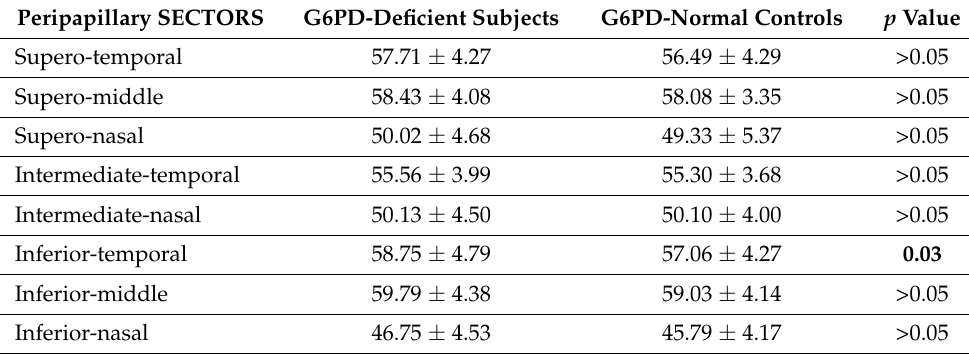
Table 2. Radial peripapillary capillary (RPC) vascular density (VD) values in glucose-6-phosphate- dehydrogenase (G6PD)-deficient patients and G6PD-normal